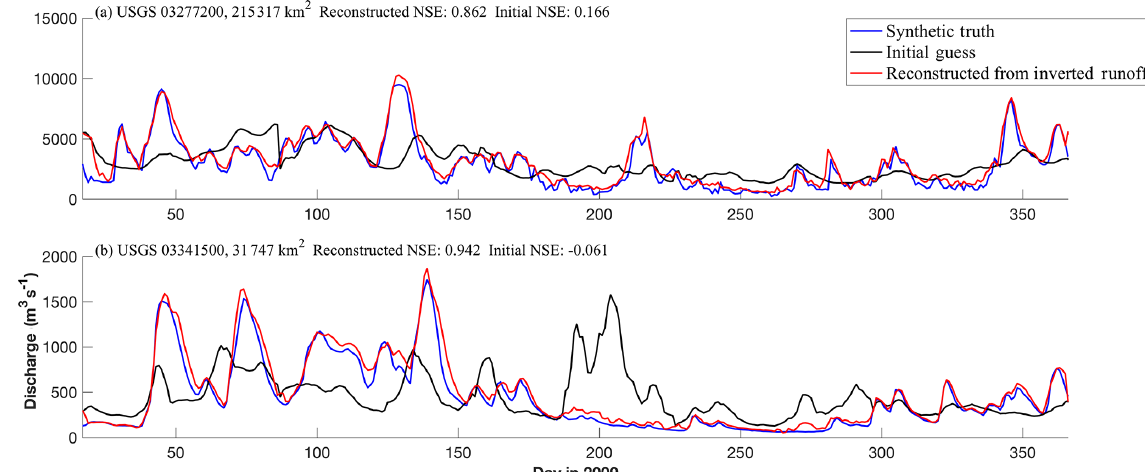
Figure 7. Reconstructed discharge time series during 2009 for 2 of the 25 evaluation sites when the ISR model was run using the climato- logical initial guess of runoff conditions. Here the discharge data assimilated and compared against (the truth) are USGS